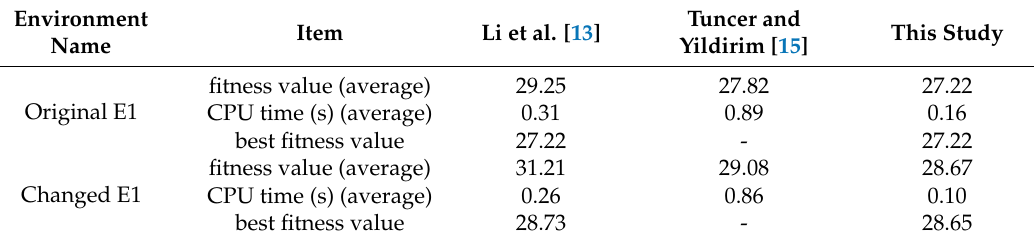
Table A1. The result of dynamic environment